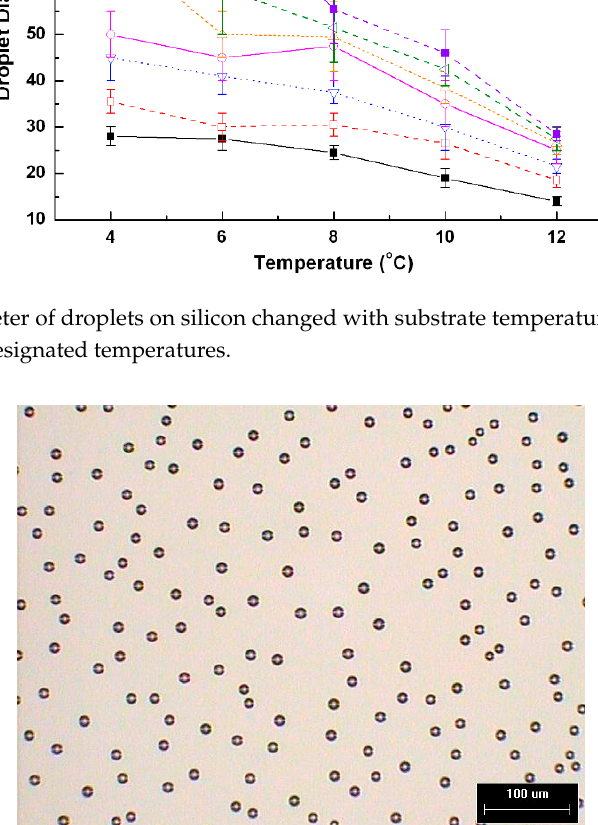
Figure 5. OM picture of condensed water droplet on silicon at 12 ∘ C for 20 s.